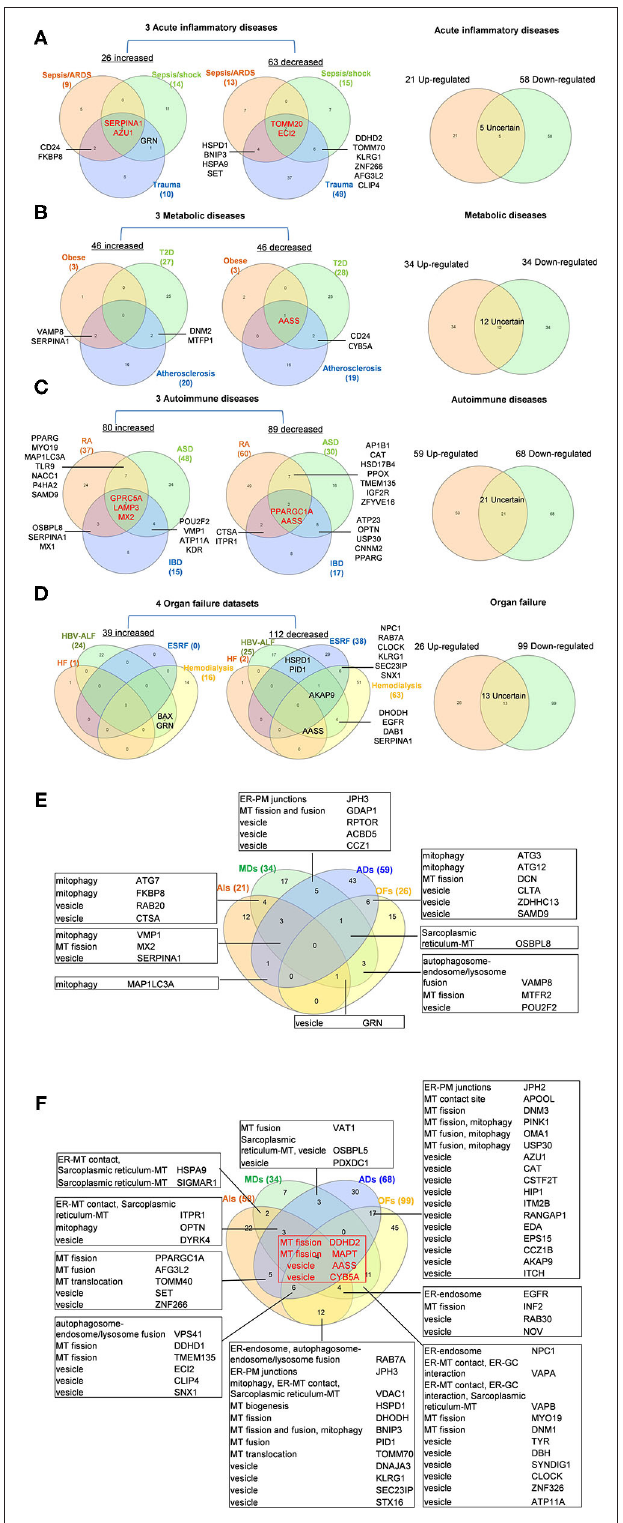
FIGURE 2 | among acute inflammatory diseases (AIs). SERPINA1 and AZU1 are shared upregulated genes; TOMM20 and ECI2 are shared downregulated genes by sepsis/ARDS, sepsis/shock, and trauma. CD24, FKBP8, and GRN are shared upregulated genes by sepsis and trauma. HSPD1, BNIP3, HSPA9, SET, DDHD2, TOMM70, KLRG1, ZNF266, AFG3L2, and CLIP4 are 10 genes that are commonly downregulated in sepsis and trauma groups. After removing five uncertain genes (upregulated in one type of disease and downregulated in another type of disease), 21 genes are upregulated and 58 genes are downregulated in AIs. (B) Venn diagram shows seven genes are shared among metabolic diseases (MDs). VAMP8 and SERPINA1 are shared upregulated genes by obese and atherosclerosis; DNM2 and MTFP1 are shared upregulated genes by type 2 diabetes (T2D) and atherosclerosis. AASS is shared a downregulated gene by three metabolic diseases, and CD24 and CYB5A are shared downregulated genes by T2D and atherosclerosis. After removal of 12 uncertain genes, 34 genes are upregulated and 34 genes are downregulated in MDs. (C) Venn diagram shows 33 genes are shared among autoimmune diseases. GPRC5A, LAMP3, and MX2 are shared upregulated genes; PPARGC1A and AASS are shared downregulated genes by rheumatoid arthritis (RA), autoimmune skin disease (ASD), and inflammatory bowel disease (IBD). Other 28 genes are common genes between two autoimmune diseases. After removal of 21 uncertain genes, 59 genes are upregulated, and 68 genes are downregulated in ADs. (D) Venn diagram shows 16 genes are shared in organ failure datasets. BAX and GRN are shared upregulated genes by hepatitis B virus-associated acute liver failure (HBV-ALF). AKAP9 is the common downregulated gene in HBV-ALF, end-stage renal failure (ESRF), and hemodialysis; NPC1, RAB7A, CLOCK, KLRG1, SEC23IP, and SNX1 are the common downregulated genes in ESRF and hemodialysis. After removal of 13 uncertain genes, 26 genes are upregulated and 99 genes are downregulated in OFs. (E) Venn diagram shows the shared and exclusive upregulated and downregulated OCRGs in these four diseases. In upregulated OCRGs, a total of 24 genes were shared by two or three different diseases. AIs and MDs shared four genes, two vesicle-related genes (RAB20 and CTSA), and two mitophagy genes (FKBP8 and ATG7). AIs and ADs shared mitophagy gene (MAP1LC3A). AIs, MDs, and OFs shared vesicle genes (GRN). MDs and OFs shared three genes autophagosome–endosome/lysosome fusion regulator (VAMP8), MT fission gene (MTFR2), and vesicle gene (POU2F2). AIs, MD, and ADs shared mitophagy (VMP1), MT fission (MX2), and vesicle (SERPINA1) genes. MDs, ADs, and OFs shared sarcoplasmic reticulum–MT gene (OSBPL8). ADs and OFs shared two mitophagy genes (ATG3 and ATG12), one MT fission gene (DCN), and three vesicle genes (CLTA, ZDHHC13, and SAMD9). MDs and ADs shared five genes including one ER–PM junctions gene (JPH3), one MT fission and fusion regulator (GDAP1), and three vesicle genes (RPTOR, ACBD5, and CCZ1). Other exclusive upregulated genes in these four diseases are listed in Supplementary Table 4A . (F) In downregulated OCRGs, a total of 67 genes were shared by two or more than two different diseases. Two MT fission genes (DDHD2 and MAPT) and two vesicle genes (AASS and CYB5A), were shared by four types of diseases (red box). ADs and OFs shared 17 OCRGs, including one ER–PM junction regulator (JPH2) and one MT contact site gene (APOOL), two MT fission regulators (DNM3 and PINK1) (also mitophagy regulator), two genes with MT fusion and mitophagy function (OMA1 and USP30), and 11 vesicle genes. AIs and OFs shared 12 OCRGs, RAB7A (ER–endosome and autophagosome–endosome/lysosome fusion), JPH3 (ER–PM junctions), VDAC1 (mitophagy, ER–MT contact, and sarcoplasmic reticulum–MT), HSPD1 (MT biogenesis), DHODH (MT fission), BNIP3 (MT fission and fusion, and mitophagy), PID1 (MT fusion), TOMM70 (MT translocation), and four vesicle genes (DNAJA3, KLRG1, SEC23IP, and STX16). MDs and OFs shared 11 OCRGs including ER–endosome genes (NPC1), ER–MT contact and ER–GC interaction regulator VAPA, ER–MT contact, ER–GC interaction and sarcoplasmic reticulum–MT regulator VAPB, two MT fission genes MYO19 and DNM1, and six vesicle genes. AIs and MDs, AIs and ADs, and MDs and ADs shared two, five, and three downregulated OCRGs, respectively. AIs, MDs, and ADs shared three downregulated OCRGs, ITPR1 (ER–MT contact, sarcoplasmic reticulum–MT), OPTN (mitophagy), and FIGURE 2 | Venn diagram shows that there are several shared OCRGs in DYRK4 (vesicle gene). AIs, MDs, and OFs shared four OCRGs (EGFR, INF2, acute inflammations (AIs), metabolic diseases (MDs), autoimmune diseases RAB30, and NOV). AIs, ADs, and OFs shared six OCRGs, VPS41 (ADs), and organ failures (OFs). (A) Venn diagram shows 17 genes are shared (autophagosome–endosome/lysosome fusion), two MT fission (Continued)